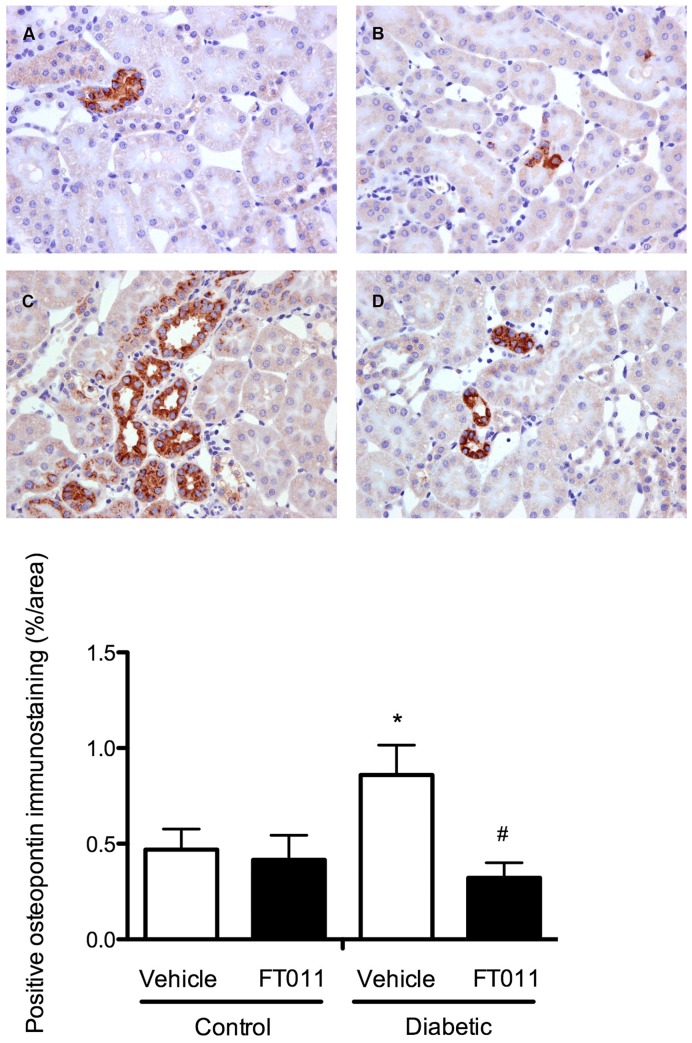
Representative photomicrograph of osteopontin immunostaining from diabetic rats.Representative photomicrographs of osteopontin immunostained sections from control and diabetic rats treated with or without FT011. In control (A) and control treated with FT011 (B) rats, only few tubules were immunostained positively for osteopontin, while diabetic rats (C) were associated with an increased in osteopontin immunostaining. Treatment of diabetic animals with FT011 (D) was associated with a significant reduction in numbers of tubules immunostained positively for osteopontin. Magnification x400. Quantitative data are expressed as mean ± SEM. *P<0.05 versus control; #
P<0.05 versus vehicle treated diabetic rats.